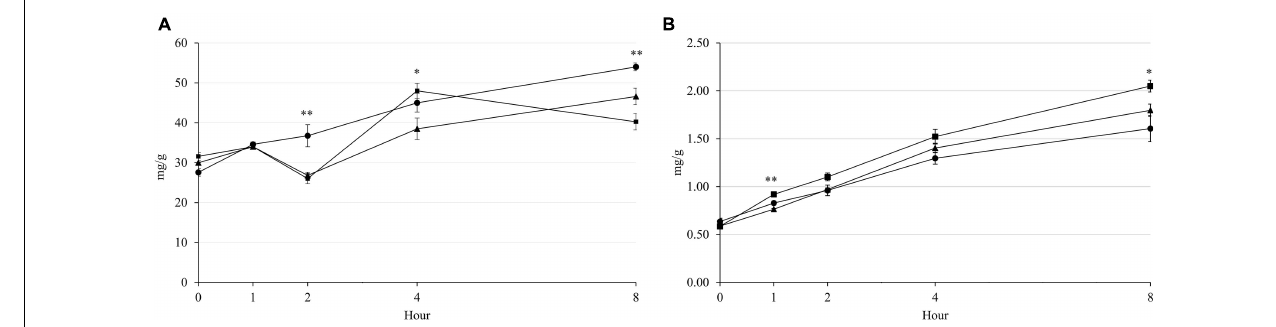
FIGURE 2 | Changes in CH 4 (A) and CO 2 (B) emissions during rumen incubation with FAs for 8 h. Diet with C18:2n-6, LA (filled circles); diet with C18:3n-3, LNA (filled triangles); and diet with the mixture of C18:2n-6 and C18:3n-3 at a ratio of 1:1 (filled squares). The respective significance levels of the supplementary treatment, incubation period, supplementary treatment × incubation period, and SEM for CH 4 and CO 2 are P < 0.001, P = 0.001, P < 0.001, and SEM = 3.021 and P < 0.001, P < 0.001, P = 0.005, and SEM = 91.69. Different symbols at the same hour differ significantly. ∗ P < 0.05; ∗∗ P < 0.01.